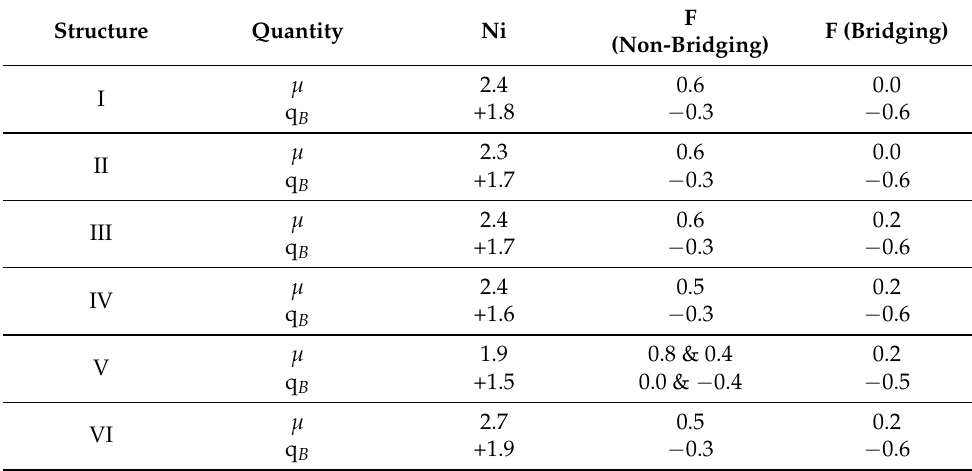
Table 5. The most frequent values for the magnitude of magnetic moments (in µ B ) and Bader charges for all the investigated structures, for nickel atoms, bridging fluorine atoms and non-bridging fluorine atoms. Magnetic moments are shown in the first rows and corresponding Bader charges in the second. F F (Bridging) Structure Quantity Ni (Non-Bridging) µ 2.4 0.6 0.0 I q B +1.8 − 0.3 −